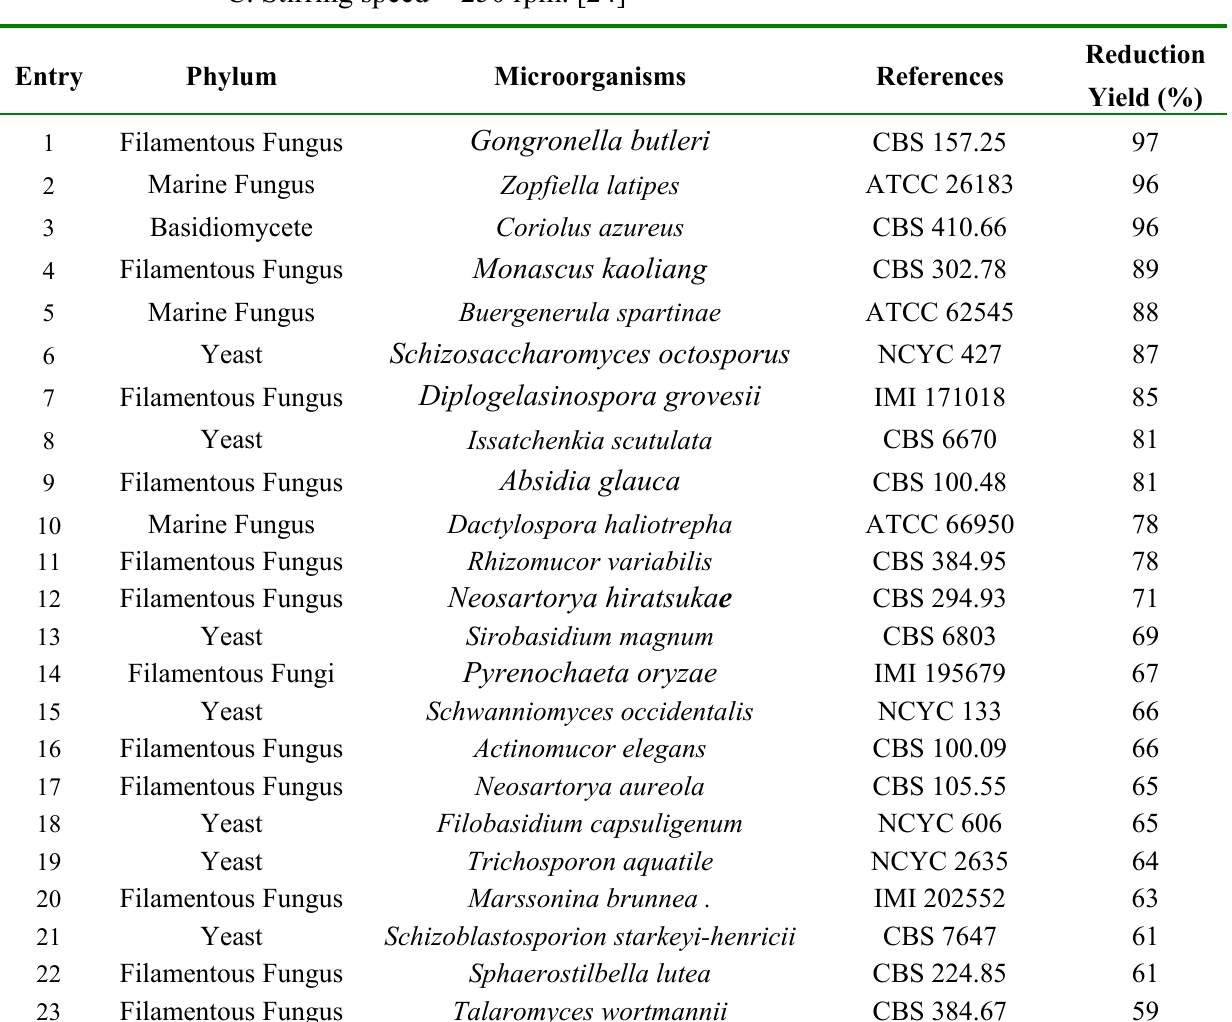
Reduction of cyclohexanone. Microorganisms that afford cyclohexanol